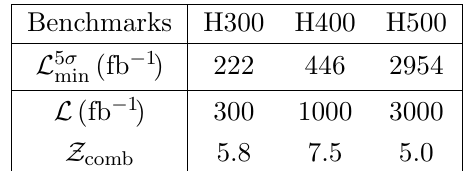
Table 9 . Combined signi(cid:12)cance Z